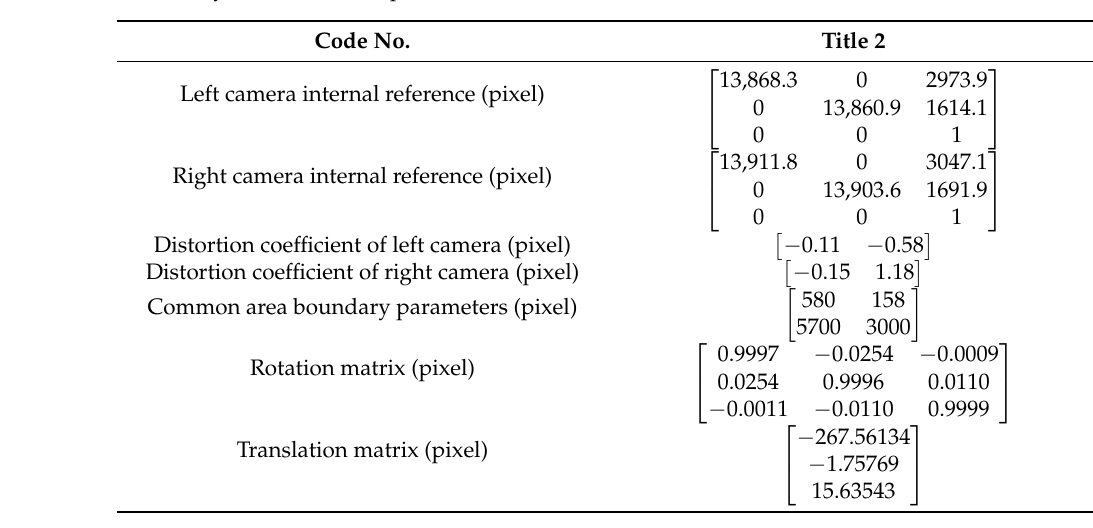
Table 1. System calibration parameters.